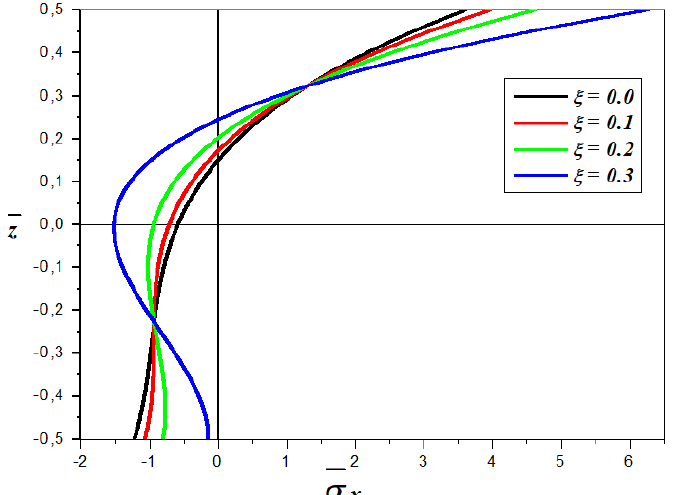
Figure 5: The thickness of FGP axial stress distribution for different porosity factor ( ξ ) (a/h=10 and p=2